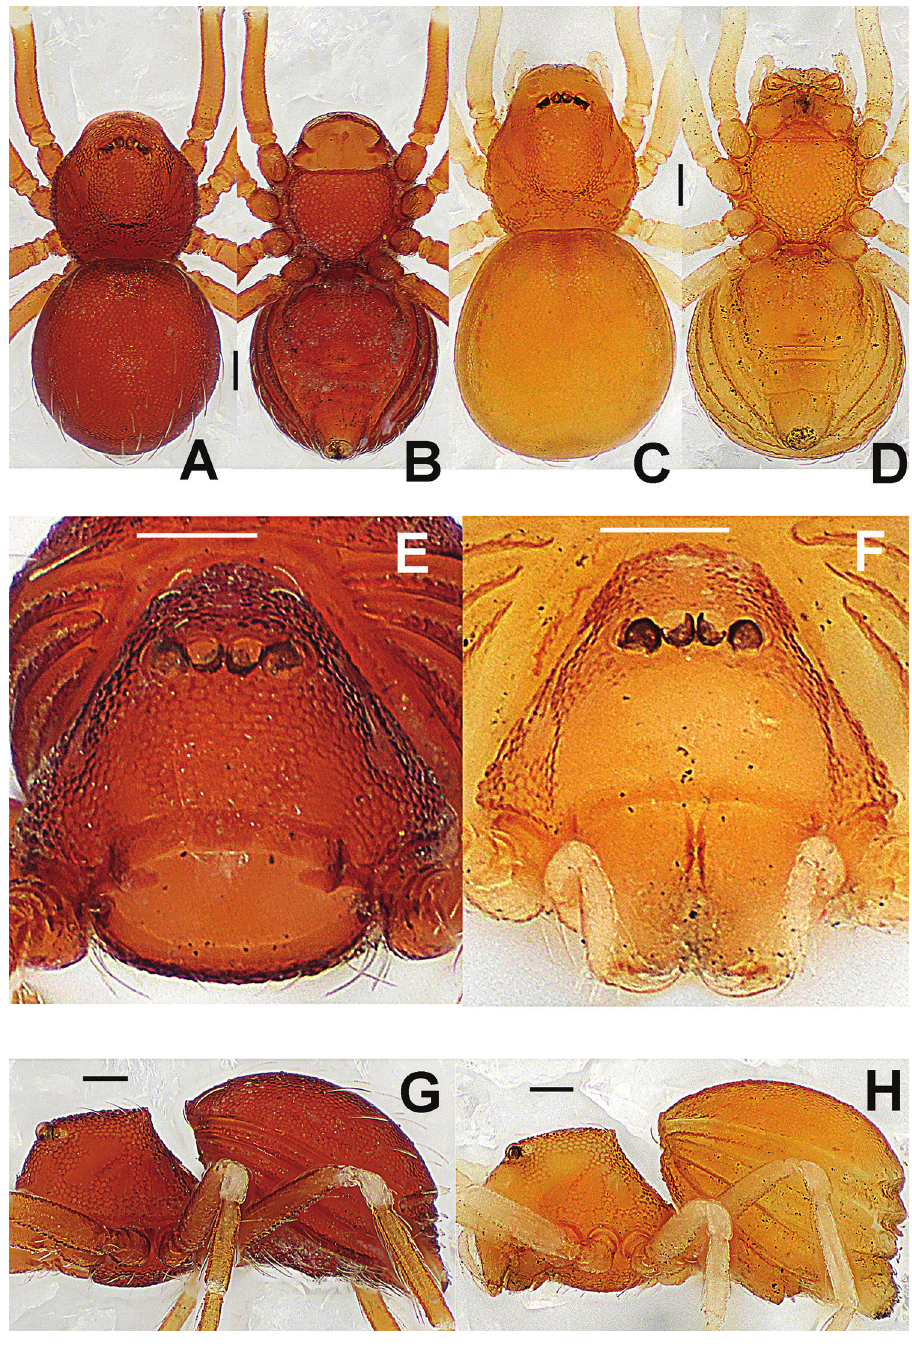
Figure 22. Singaporemma singulare Shear, 1978, male holotype ( A–B, E, G ) and female paratype ( C–D, F, H ). A–D, G–H habitus E–F prosoma. A, C dorsal B, D ventral E–F anterior G–H lateral. Scale bars: 0.10